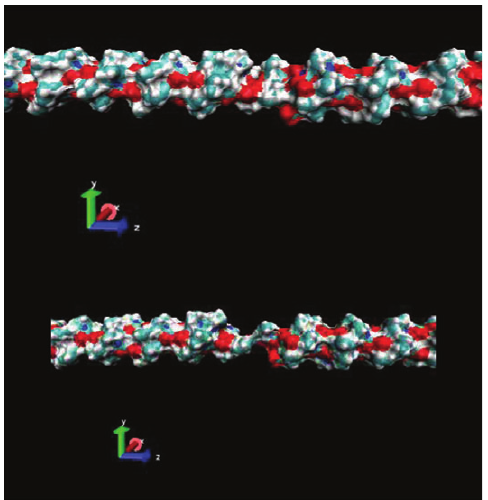
Figure 7 Collagen “ molecular necking ” during the stress-strain numerical